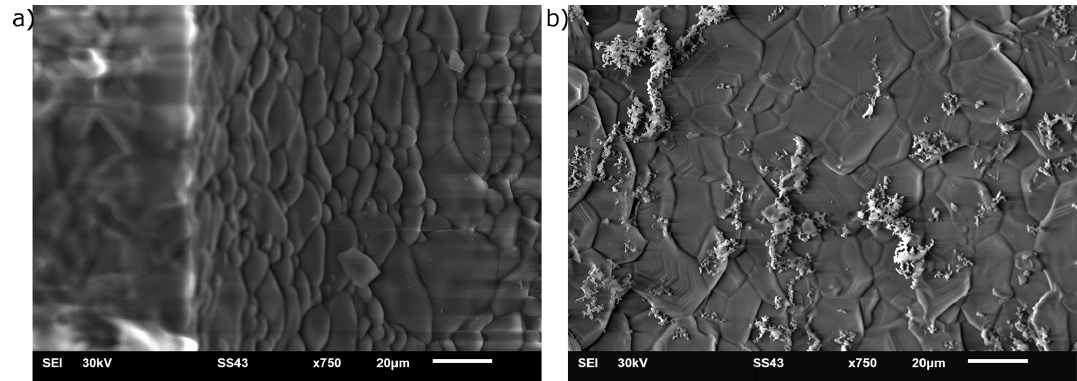
Figure 6. Scanning electron microscope (SEM) pictures of the inner surface of a ceramic tube at two different positions. (a) shows a part located outside of the hot area, where the typical structure of Al 2 O 3 (ceramic) can be seen. (b) shows a part located inside the hot area (1723K), where the ceramic is obviously partly covered with structures that might originate from carbon. Both pictures are taken with a magnification of 750.